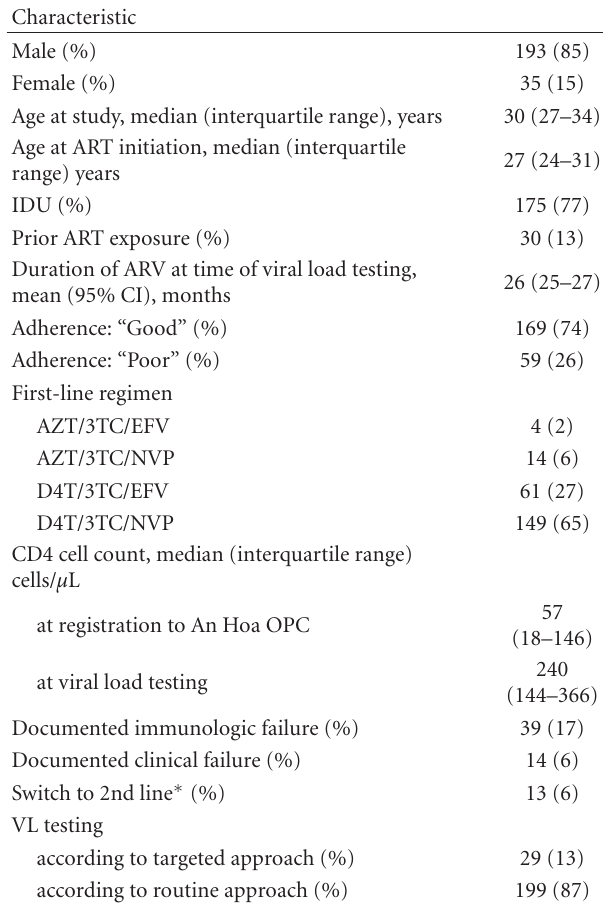
Table 1: Baseline characteristics of patients on ART > 1 yr who received VL testing, N =